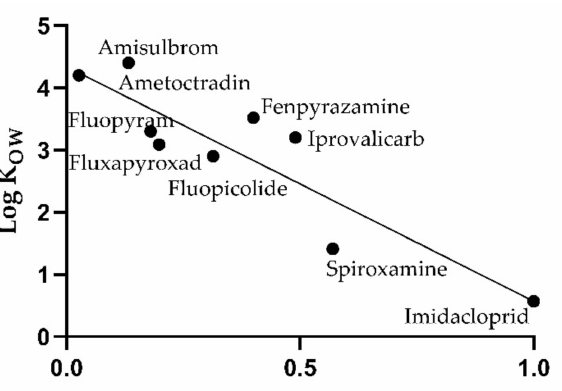
Figure 5. Correlation of median processing factors with octanol-water partition coefficients of pesticides for red wines produced by